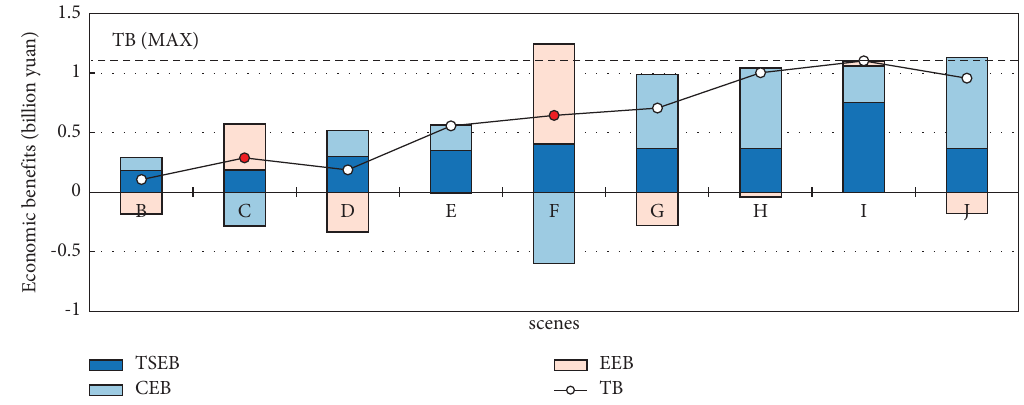
Figure 8: Te economic benefts in diferent scenes under Beijing’s trafc